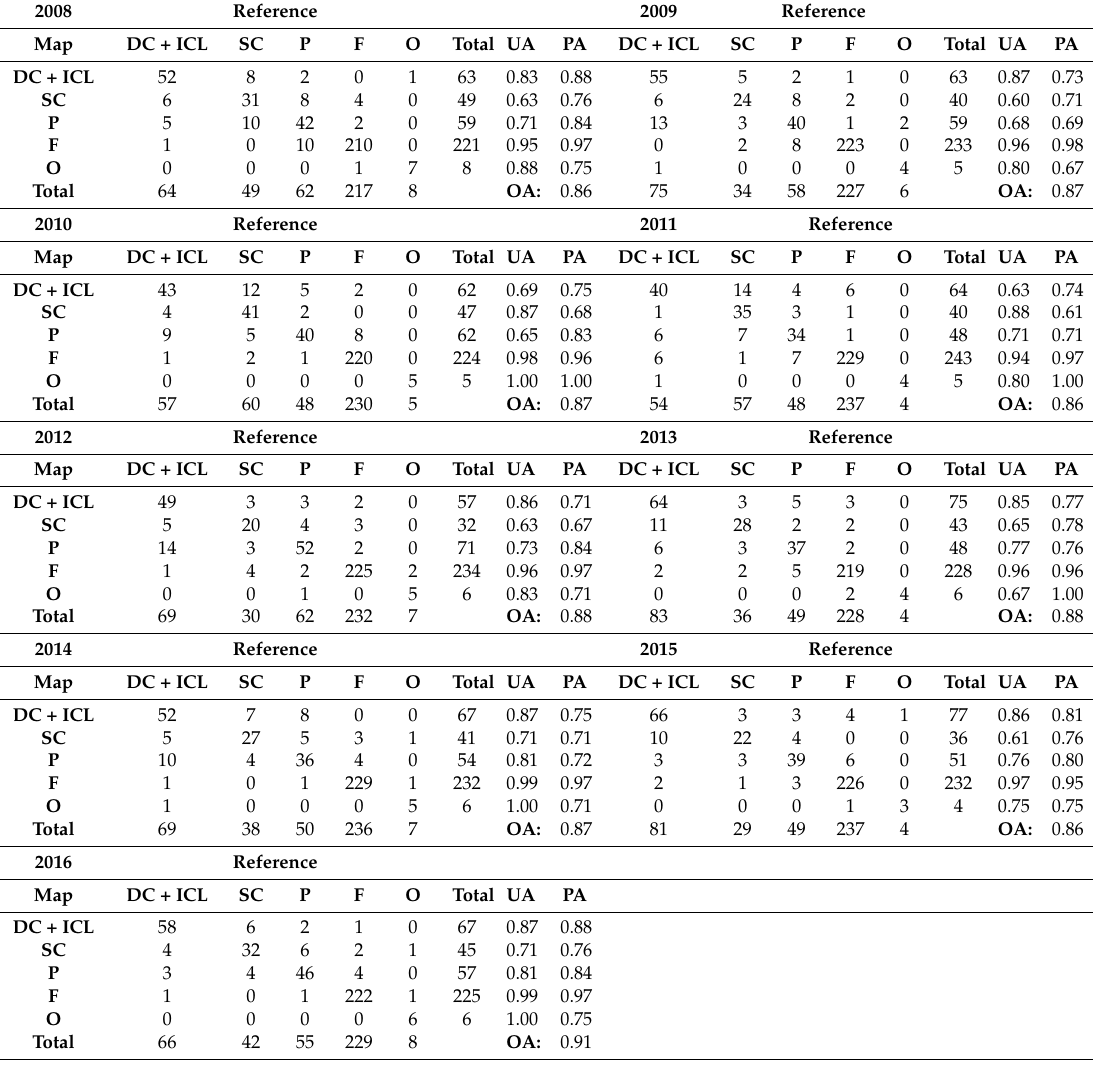
Table 3. Confusion matrices and accuracy statistics for Phase 1 classification, validation on randomly selected control points. Note: P, pasture; F, forest; O, other uses; UA, user´s accuracy; PA, producer´s accuracy; OA, overall accuracy.